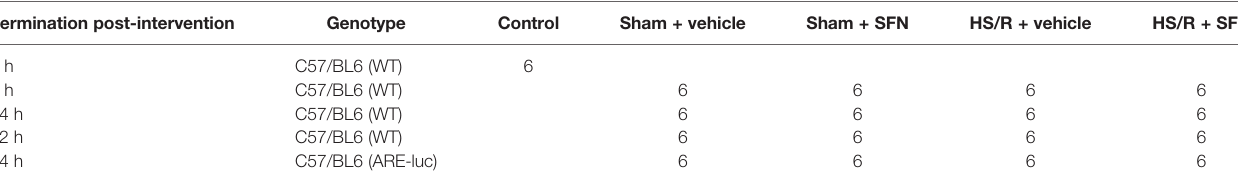
TABLE 1 | Groups distribution of WT and ARE-luc